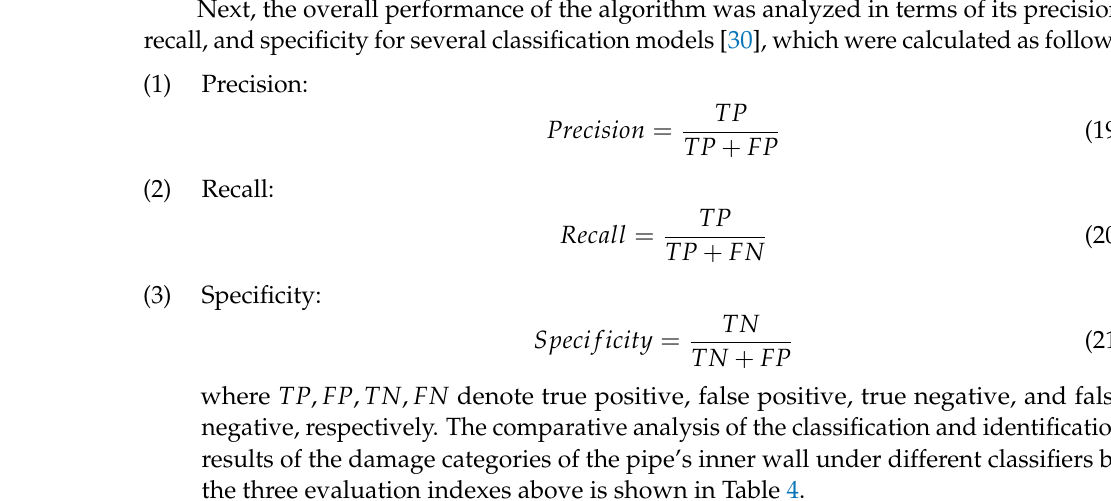
Table 4. Comparison of test classification results for the pipe corrosion sample set.